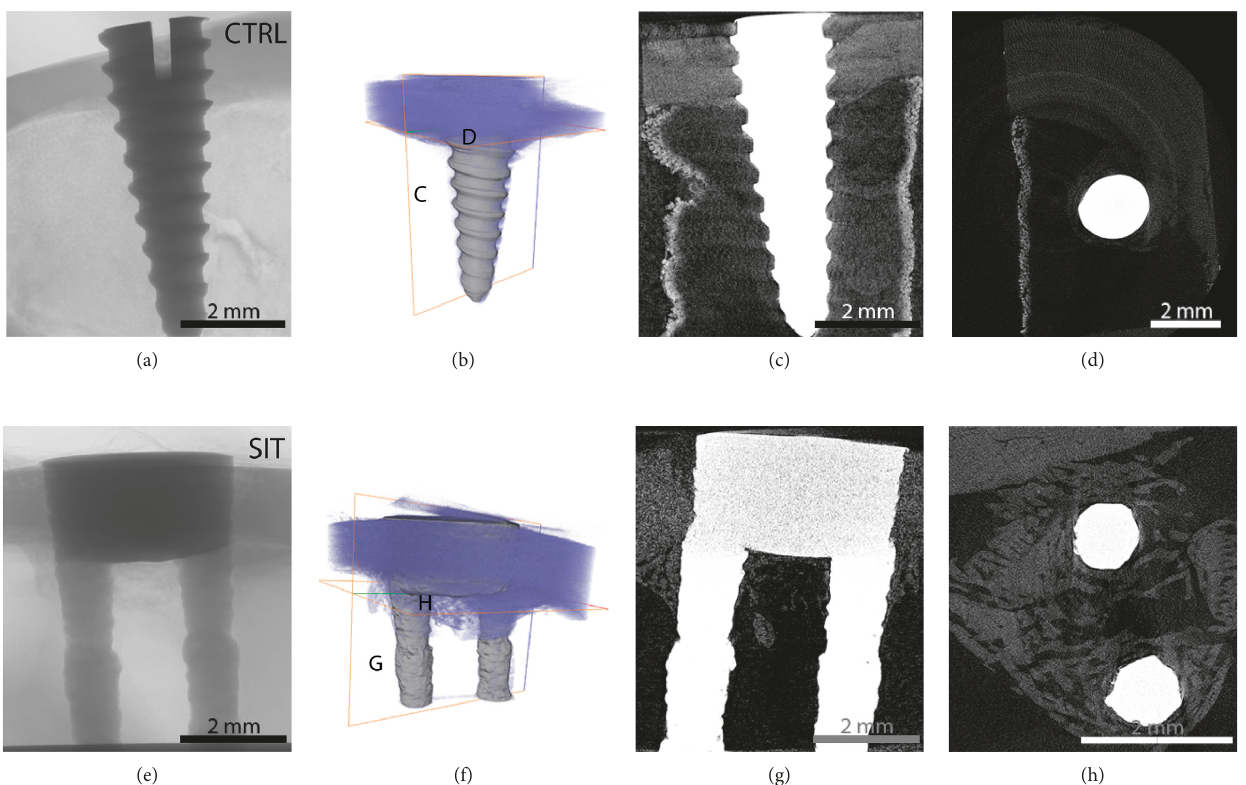
Figure 5: Micro-CTanalysis following 3-week implantation of CTRL (left column) and SIT (right column) implants. (a, e) Radiographs of each implant type. (b, f) 3D visualization of the implant and bone (purple) with orthogonal planes labelled, (c, d, g, h) corresponding orthoslices from (b, f) where new bone formation (appears lighter in contrast) is noted. Both implants showed bone conduction down the implants from the cortical bone crest, while the SIT implant also showed new bone formation between the implant